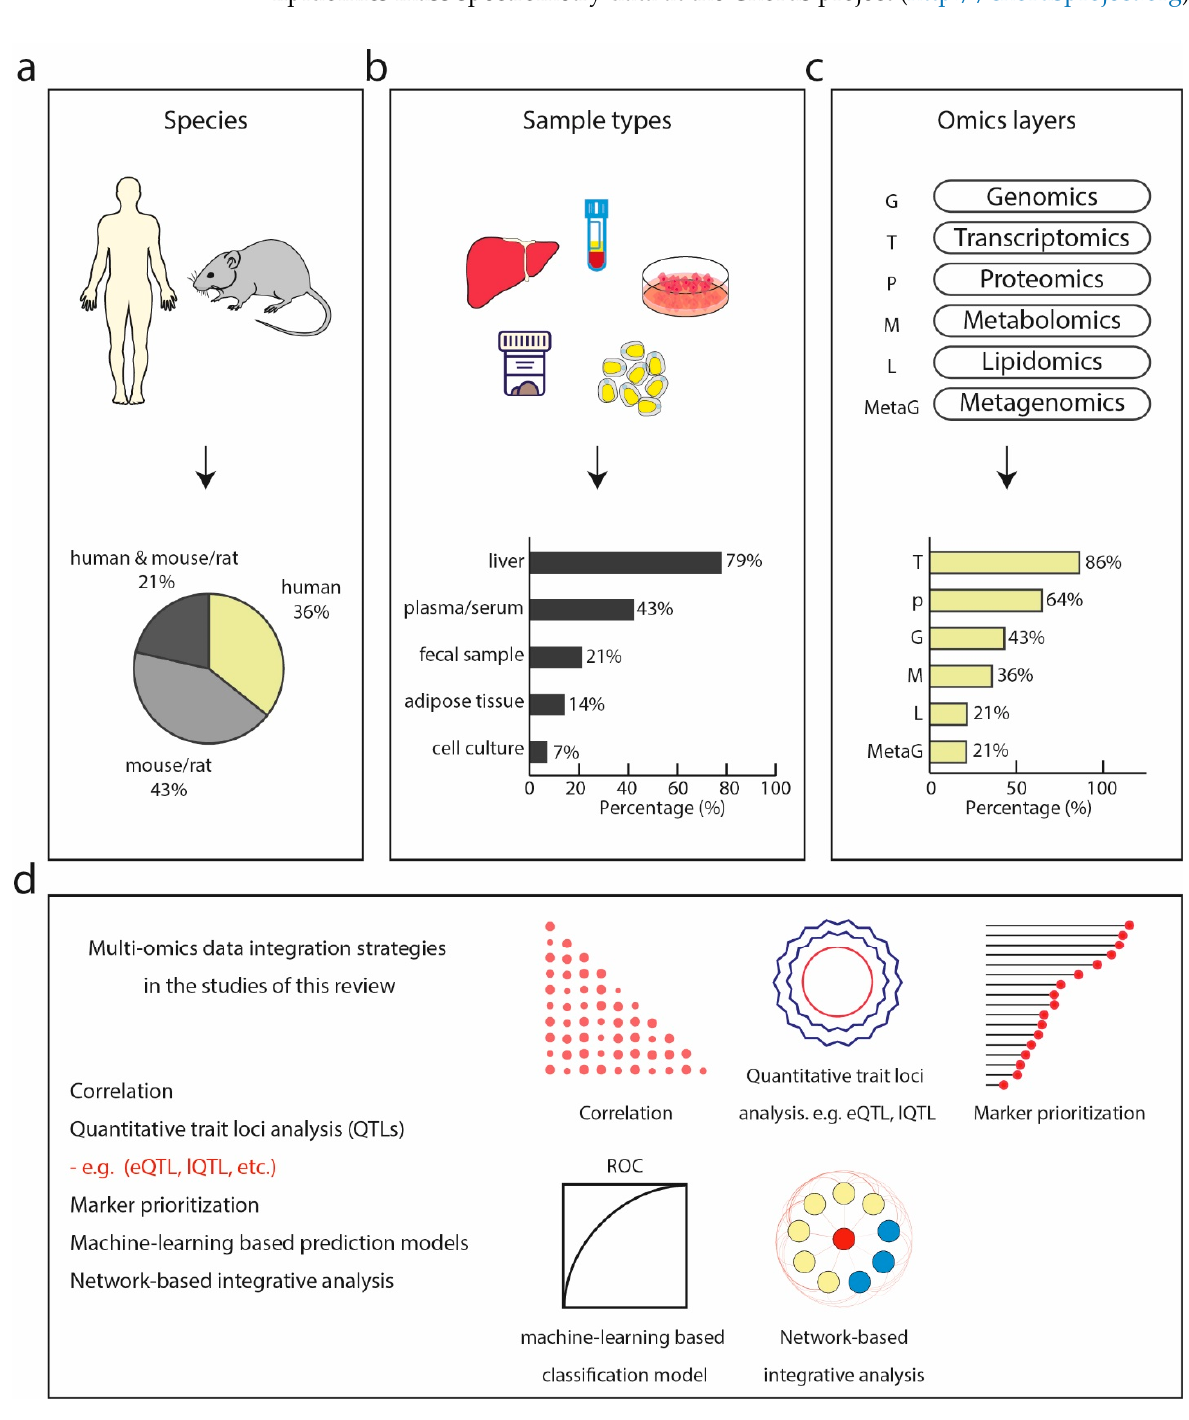
Figure 2. Multi-omics studies in NASH. ( a ) Species of which bio-specimens were used in the surveyed studies including human, model organisms such as mouse and rat, or a combination of both. ( b ) Sample types collected and analyzed by omics technologies in the surveyed studies, dominated by liver, followed by plasma or serum, fecal samples, adipose tissue, and cell culture. ( c ) Omics technologies used in the surveyed studies with transcriptomics being the most commonly used, followed by proteomics, genomics, metagenomics, lipidomics, and metagenomics. ( d ) Multi-omics integration strategies used in the surveyed studies.